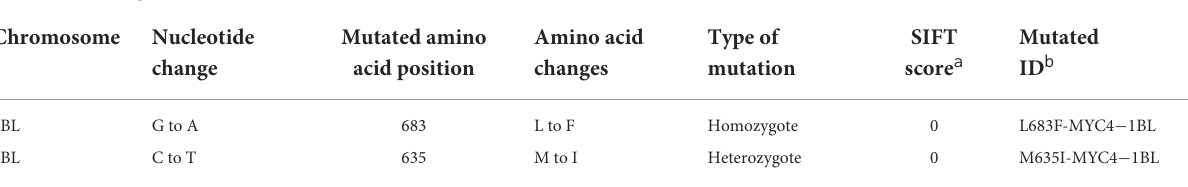
TABLE 1 Summary of identified TaMYC4 − 1BL Cadenza mutants.